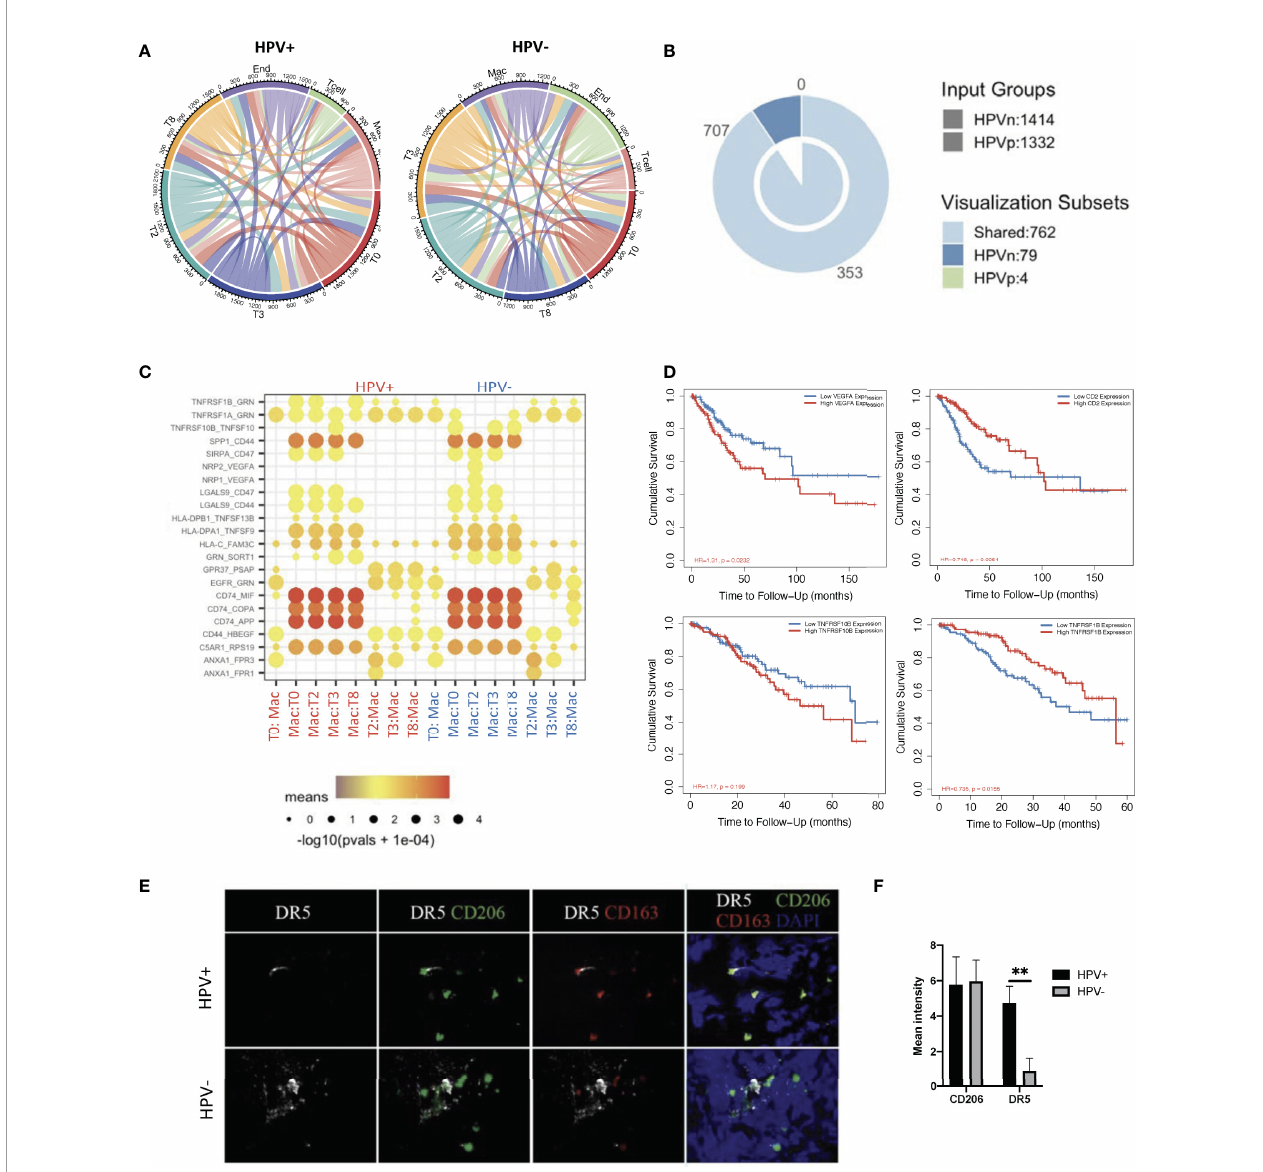
FIGURE 5 | Cell-cell communication between immune cells and HPV + tumor cells. (A) A network of interactions between immune and either HPV + or HPV - tumor cells. The lines represent the pointing relationships. (B) A Venn diagram showing the shared and unique cell-cell interactions of immune cells with HPV + or HPV - tumor cells. (C) Dot plots showing the most signi fi cant interactions (mean>1) of macrophages with either HPV + or HPV - tumor cells and the signi fi cance of their relationships. The horizontal coordinates are cell type interactions and the vertical coordinates are protein interactions, with the larger dots indicating smaller p-values and the colours representing the average expression. (D) Kaplan-Meier survival analysis of VEGFA, CD2, TNFRSF10B and TNFRSF1B in the CSCC patients. Representative immunostained photomicrographs of TNFRSF10B/DR5 (E) on the biopsied sections from HPV + or HPV - patients. CD206 and CD163 staining refer to the tumor in fi ltrated macrophages. Scale bar indicates 15 m m. (F) Bar graphs showing the quanti fi cation of TNFRSF10B DR5 and CD206 respectively. ** indicate p<0.01 of six